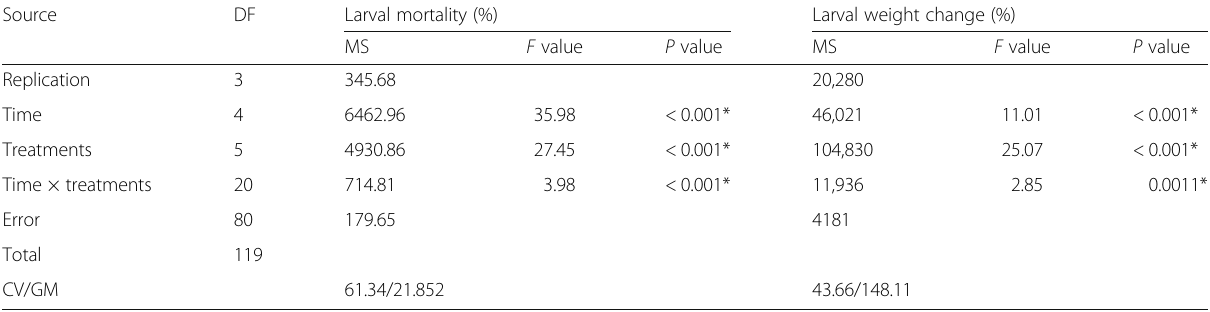
Table 2 Analysis of variance comparison of mortality of the third-instar larvae of Helicoverpa armigera Hübner bioassayed with soil isolated strain of Bacillus thuringiensis applied without 1.0% MgCl 2 salt